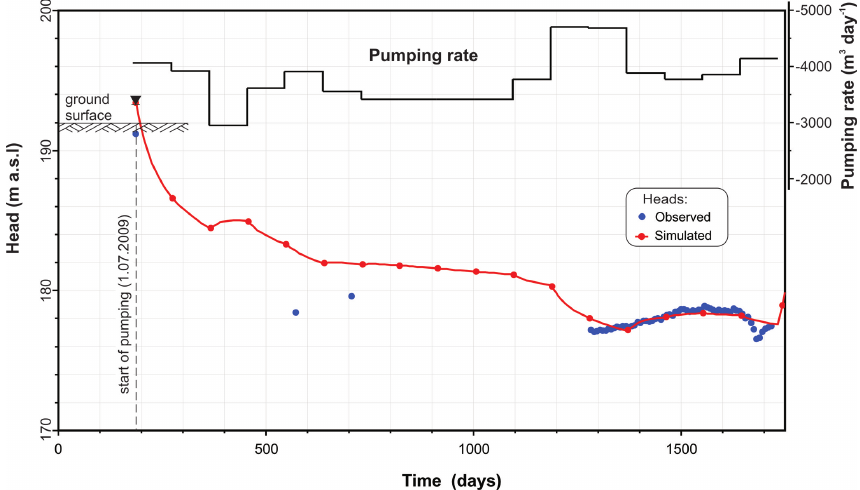
Figure 12. Changes of the hydraulic head in well no. 32 (see Fig. 2) after initialization of the operation of Wola Batorska well field in July 2009.